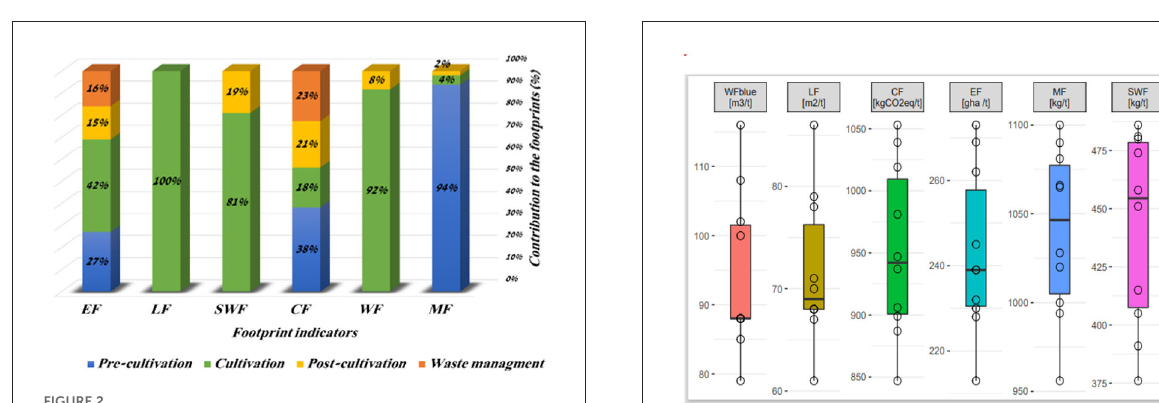
FIGURE2 Production stages contribute to footprints. Relative contribution of the four production-stages included in the research to the six footprints indicators. The ratios are expressed in percentage out of the total value of each footprint.